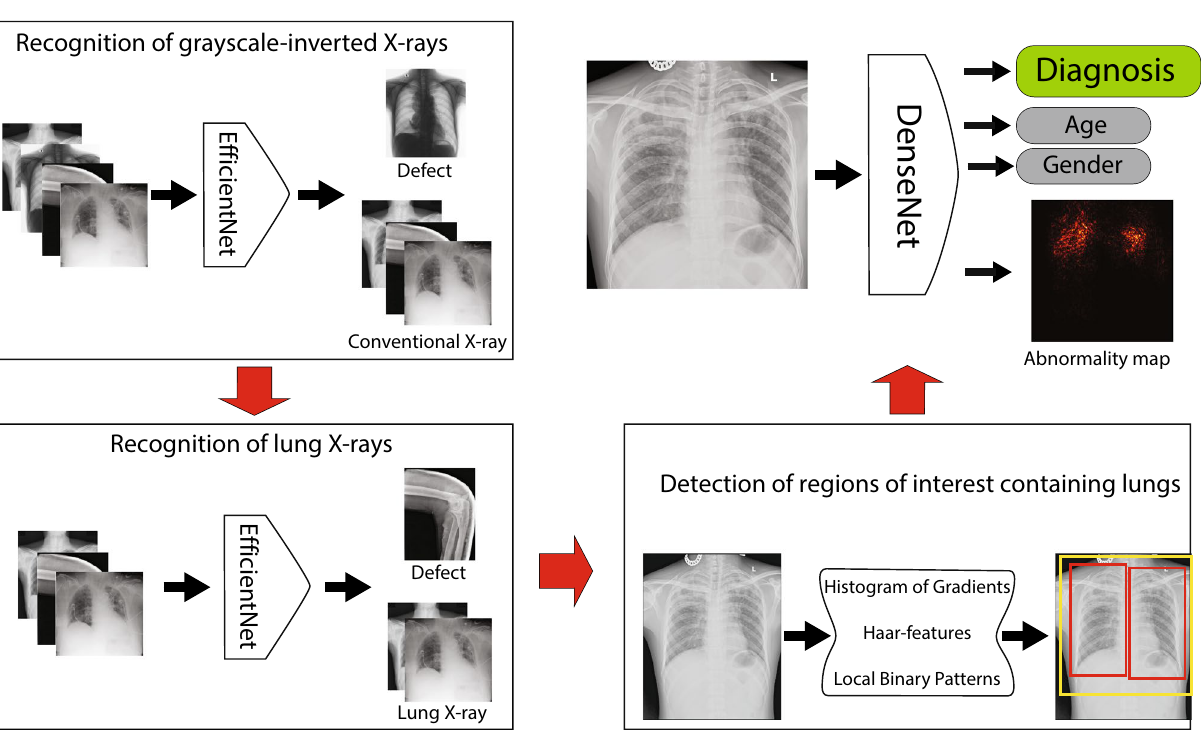
Figure 4. The schematic illustration of the proposed framework consisting of several components for (1) identification of grayscale inverted X-rays, (2) non-lung X-ray images, (3) lung region of interest selection, and automated